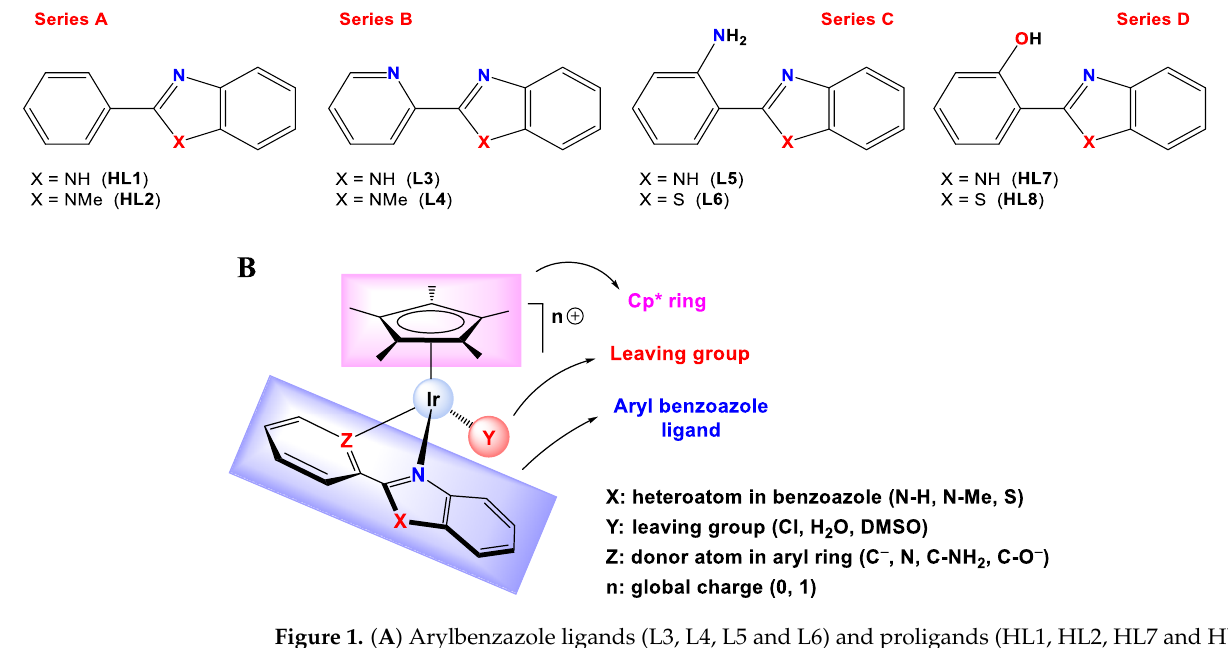
Figure 1. ( A ) Arylbenzazole ligands (L3, L4, L5 and L6) and proligands (HL1, HL2, HL7 and HL8) used in this work. ( B ) Schematic molecular structure of complexes studied in this work showing variable atoms.